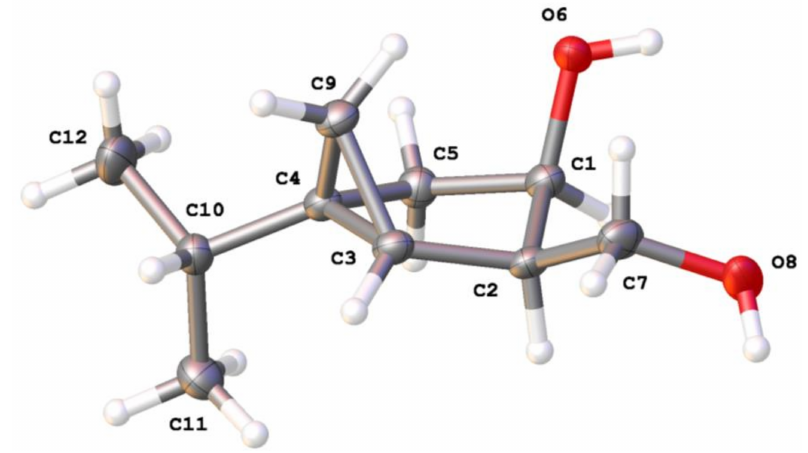
Figure 2. Crystal structure of compound 11 . Thermal ellipsoids are drawn at the 50% probability